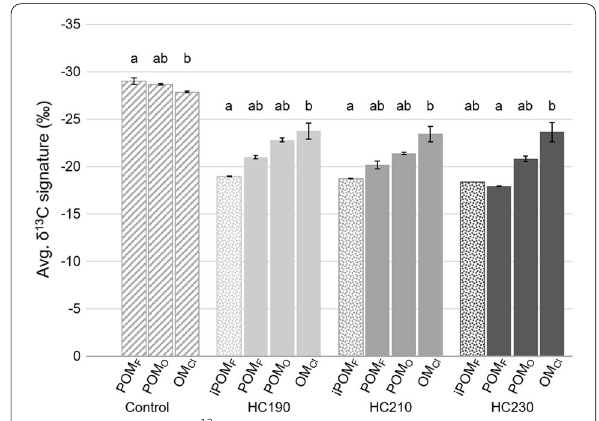
Fig. 2 The average δ 13 C signatures (‰) of the major soil organic matter (SOM) fractions for the control and hydrochar (HC)-amended soils. The average calculated initial δ 13 C signatures (‰) of each HC-amended soil is presented as iPOM F , which is the POM fraction just after adding HC. Error bars represent standard deviation of the means. Different letters indicate significant differences ( p < 0.05) in means between